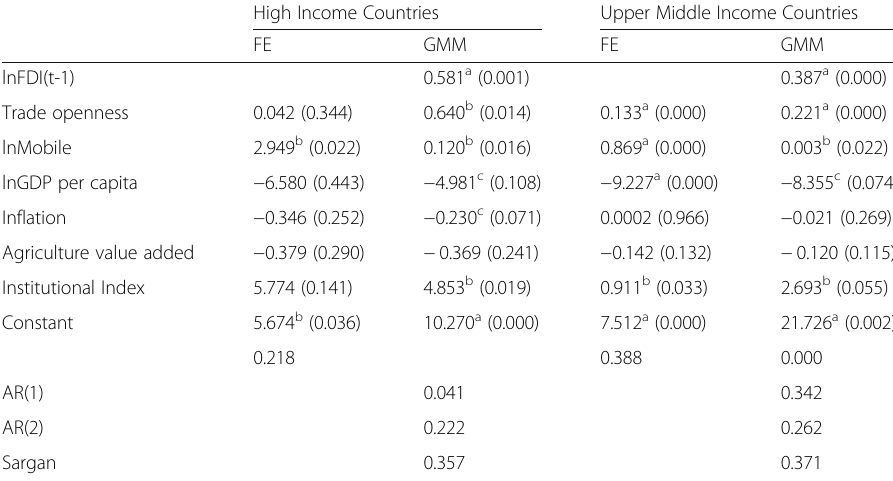
Table 2 Estimation Results for Developed Countries High Income Countries Upper Middle Income Countries FE GMM